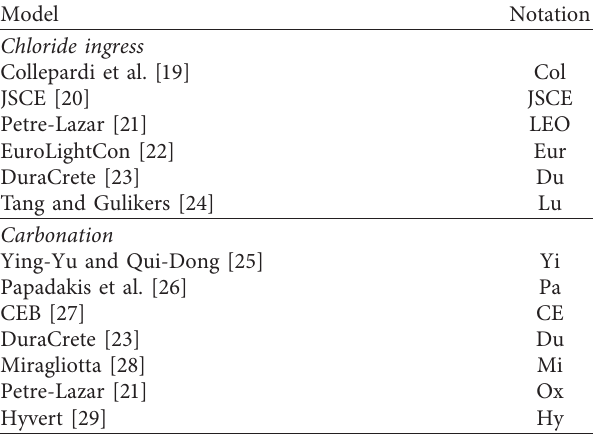
Table 1: Analytical models of concrete carbonation and chloride